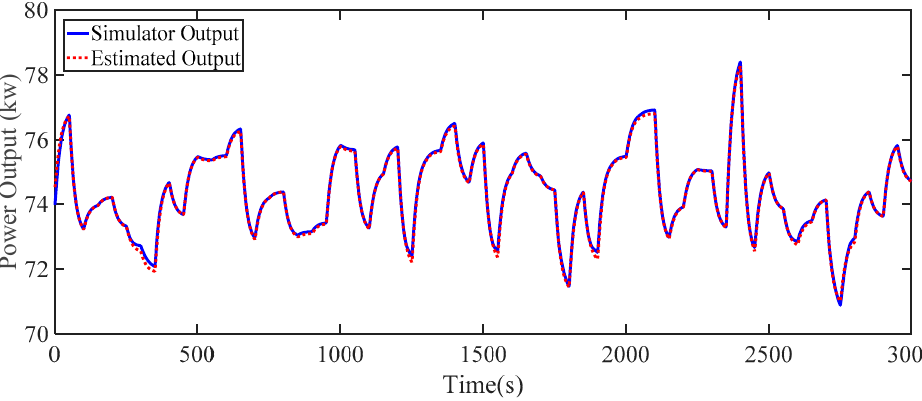
Figure 7. Estimated output and true output (power generation system).